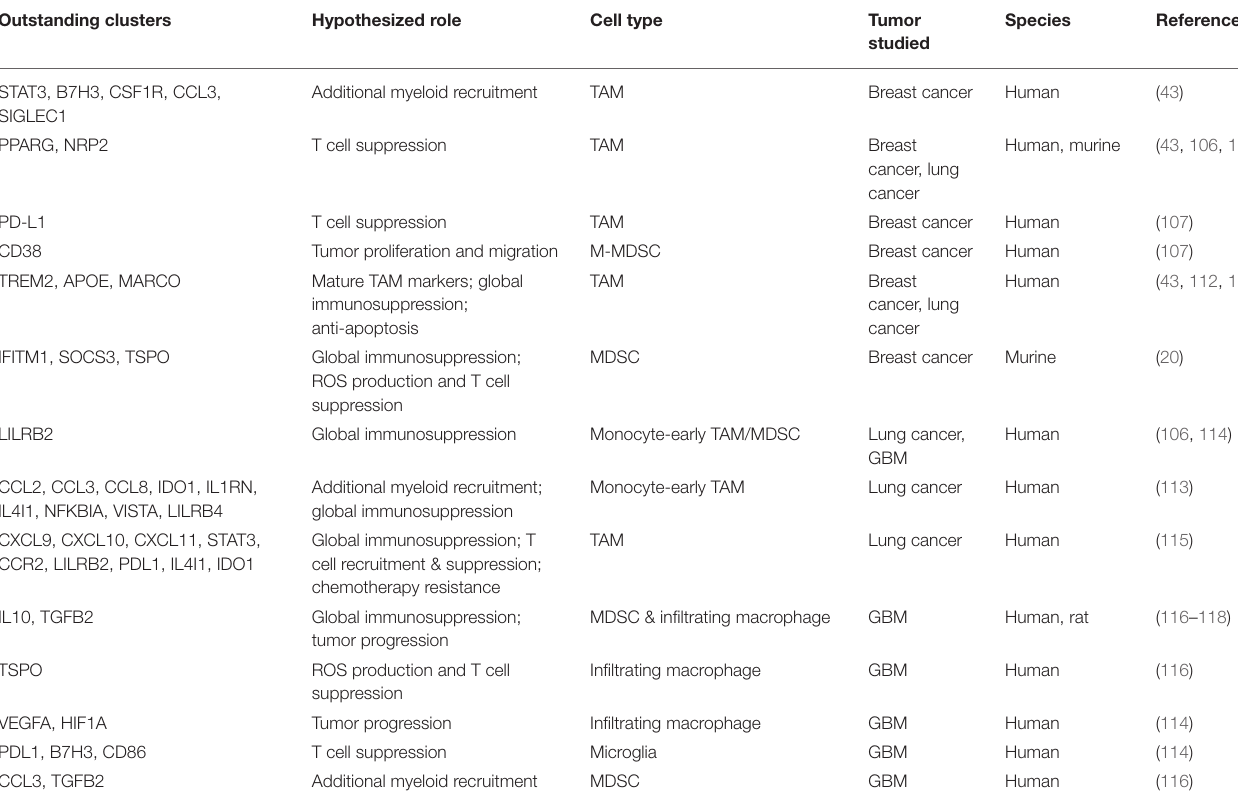
TABLE 2 | Specific clusters of myeloid cells highlighted in the text are summarized here. Outstanding